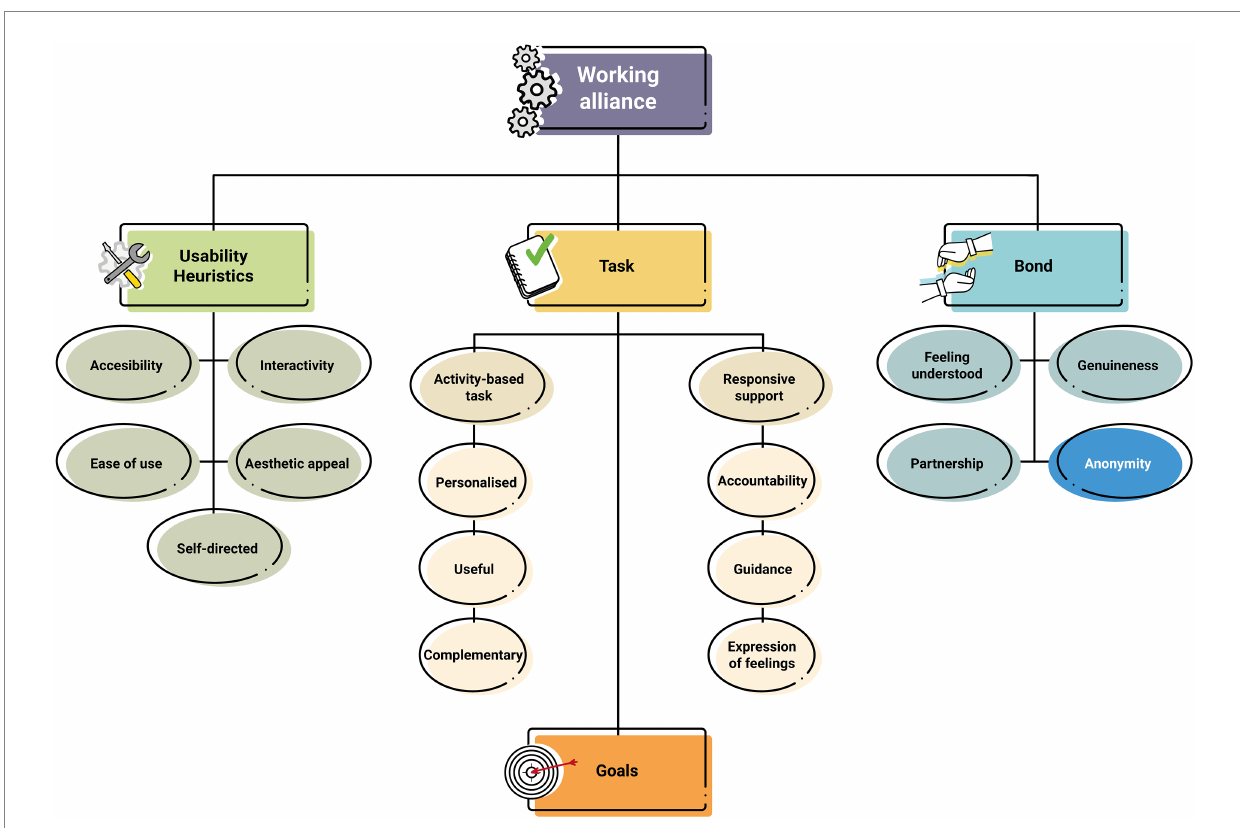
FIGURE 1 Working alliance demands in a low-intensity online CBT intervention. The new category added to the model that emerged in the Spanish Primary Care setting in patients with mild–moderate depression (i.e., “Anonymity”) is highlighted. Figure adapted from Doukani et al.